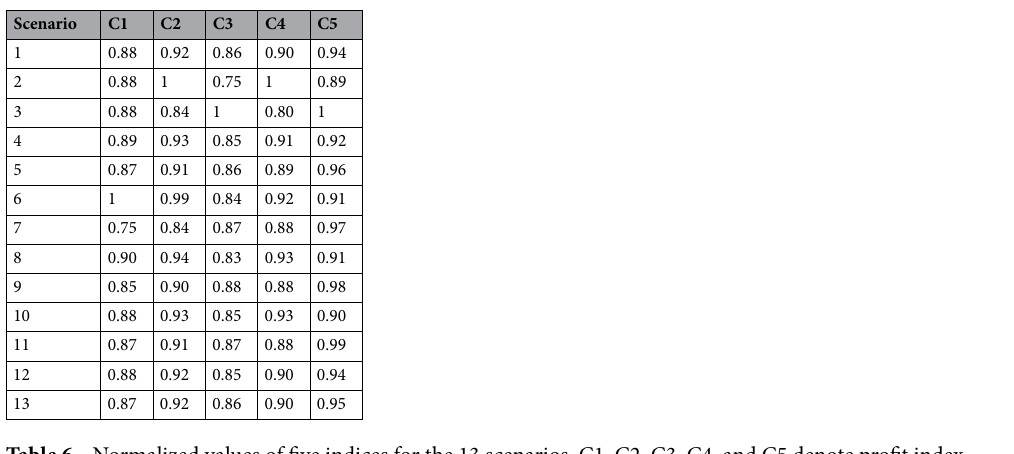
Table 6. Normalized values of five indices for the 13 scenarios. C1, C2, C3, C4, and C5 denote profit index, employment index, return of surface water, groundwater sustainability index, and total allocated water,